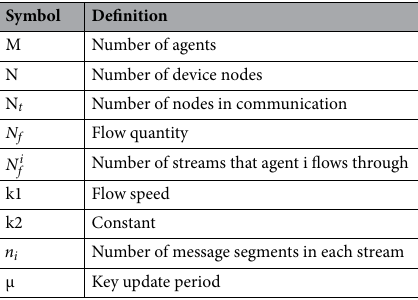
Table 6. Definitions of symbols in the ZbSR